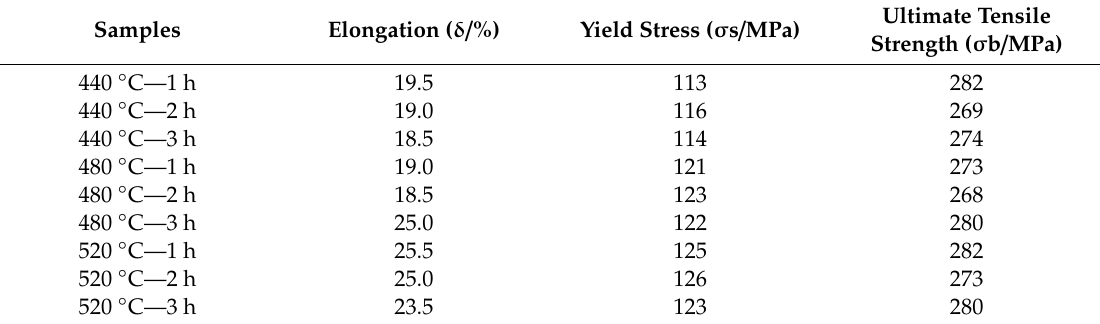
Table 10. Tensile properties of the samples after post heat